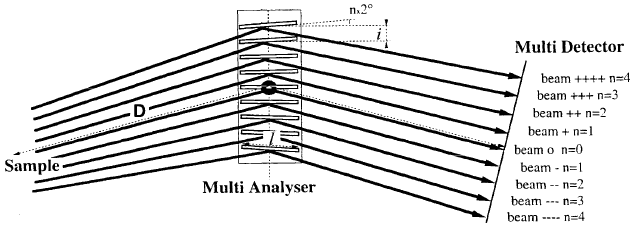
Figure 1 Scheme and beam paths on a multi-analyser diffraction (MAD) filter using nine analyser crystals with a 2 (cid:3) pitch between them; to avoid interception/cutting of the beams coming from the sample by the neighbouring analyser crystals, the maximum length of the analyser crystals l must be small and their spacing i must be relatively large; this is facilitated by the use of a large sample-to-MAD-filter distance D (from Hodeau et al. ,